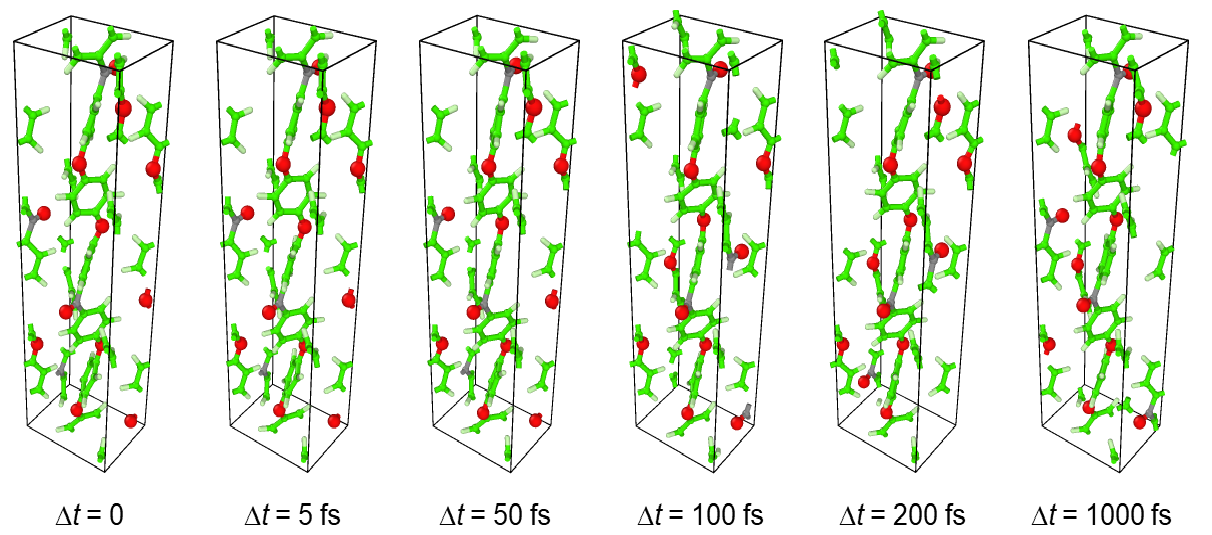
Figure 5. Snapshots of MD simulation of a unit cell of PEEK under NPT ensemble at 300 K and 1 atm.